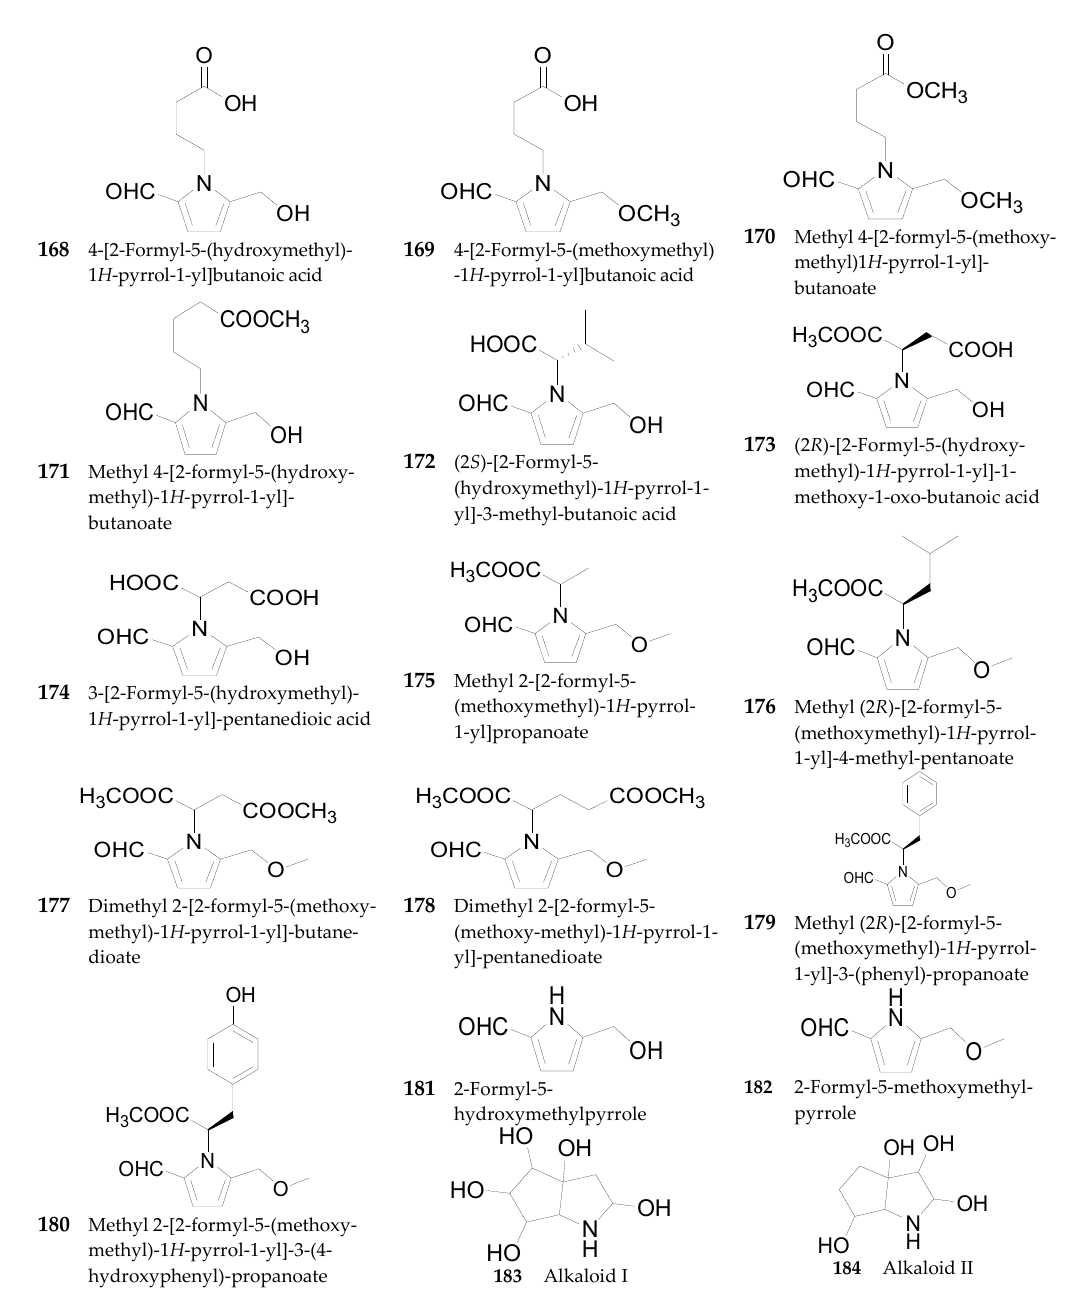
Figure 12. Chemical structures of compounds 168 – 184.